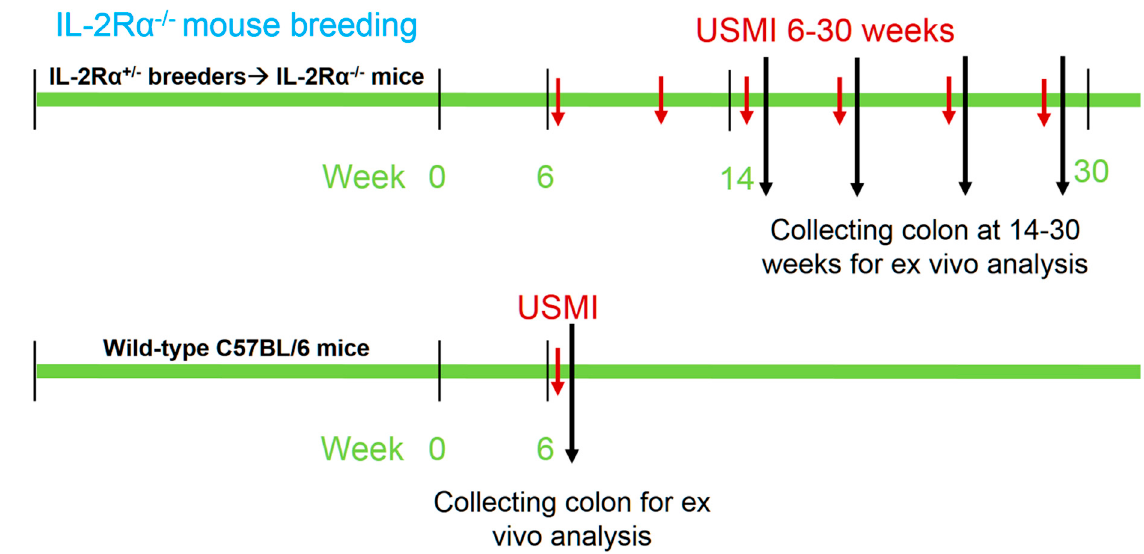
Figure 1. Overall experimental design.